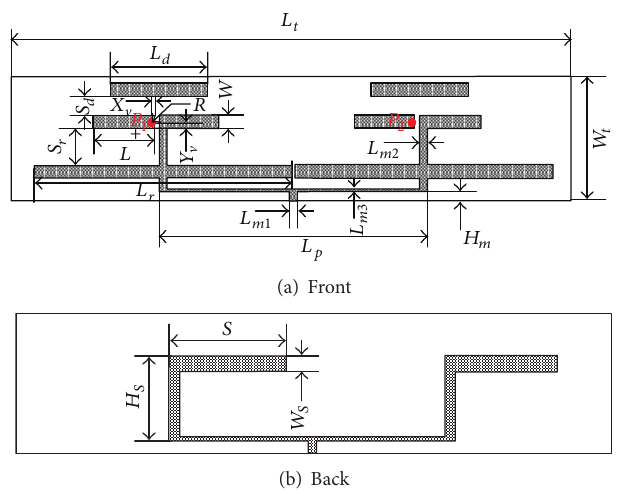
Figure 1: A schematic of the proposed antenna. 𝑃 1 and 𝑃 2 represent two metallized via holes.